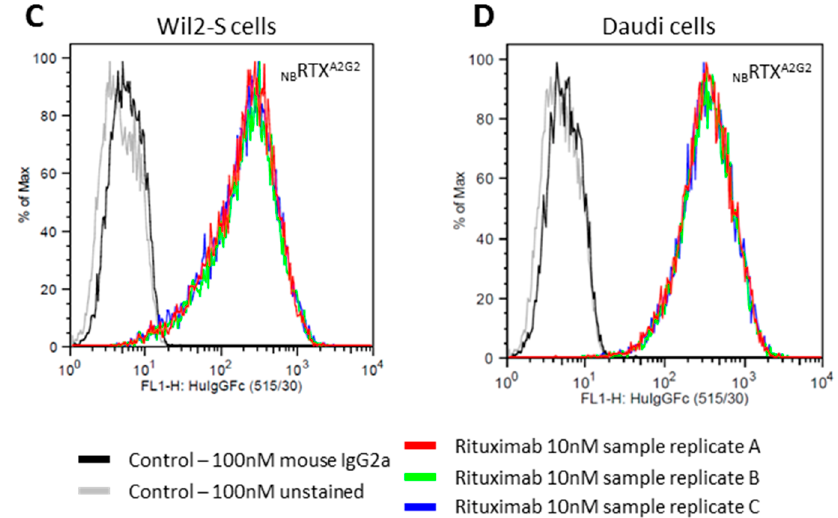
Figure 4. Binding of Rituxan ® ( A , B ) and Nb RTX A2G2 ( C , D ) to Wil2-S and Daudi cells analyzed by flow cytometry. Rituxan ® and Nb RTX A2G2 were used at a concentration of 10 nM. All rituximab samples were measured in triplicates (red, green and blue lines). FITC-labeled mouse IgG2a (black line) and unstained cells (grey line) were used as controls. The X-axis represents the fluorescent signals of FITC whereas the Y-axis presents % of cell count.